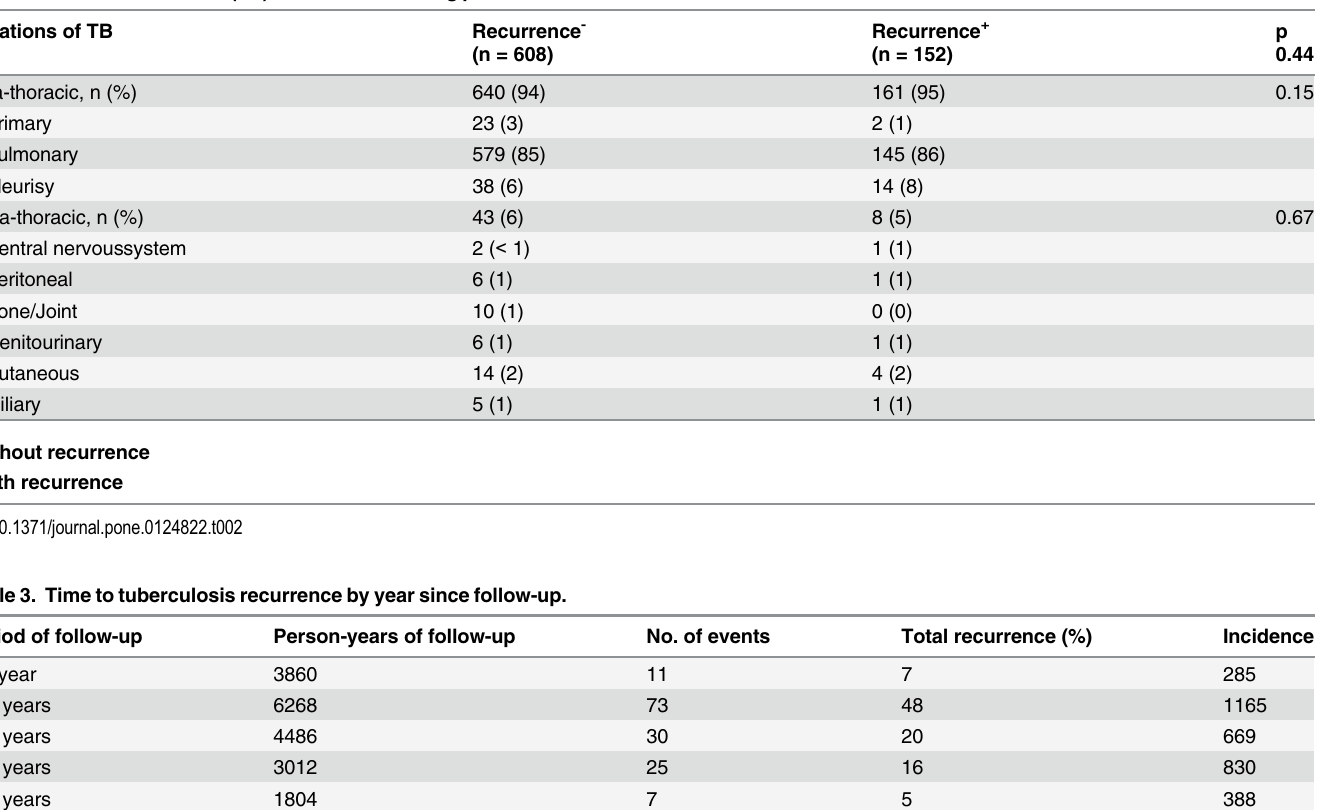
Table 2. Site of tuberculosis (TB) involvement among patients with and without TB recurrence.